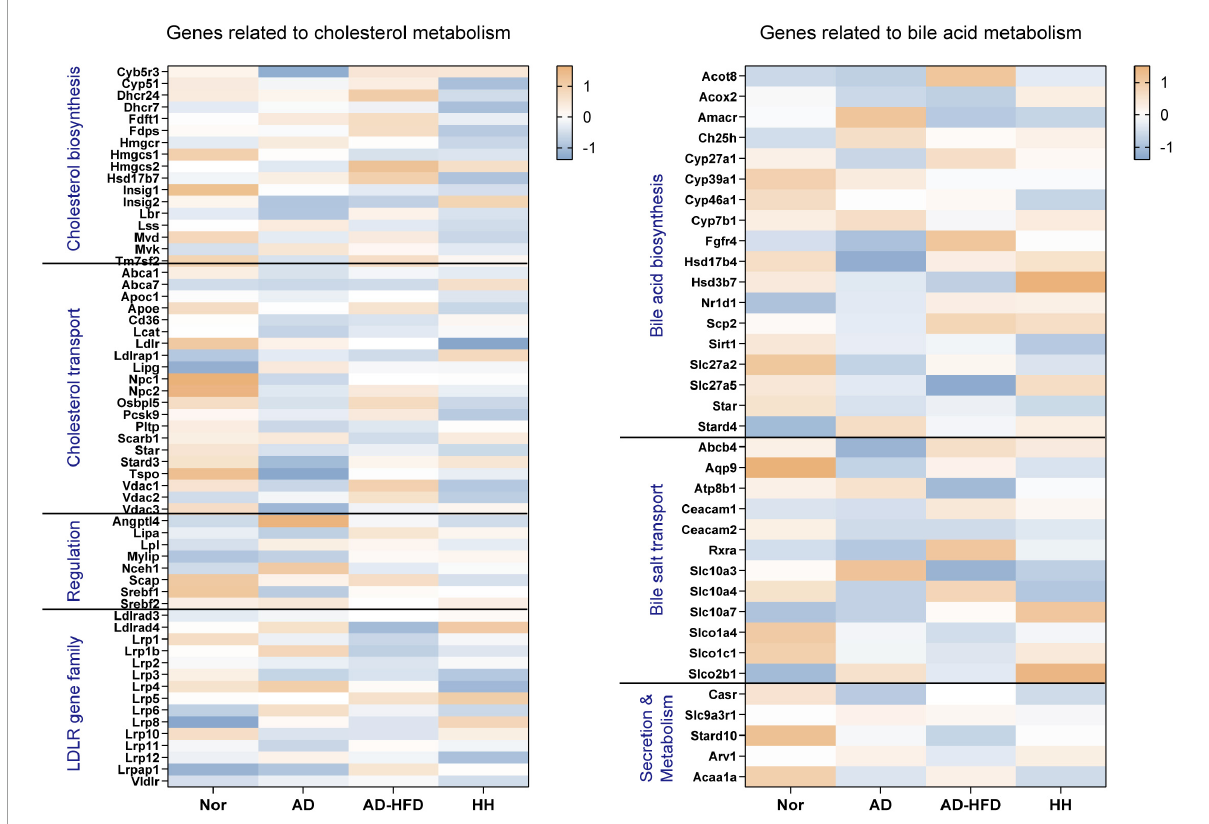
FIGURE4 Heatmap of cholesterol and bile acid-related genes in the transcriptome. Blue represents the lowest while orange represents the